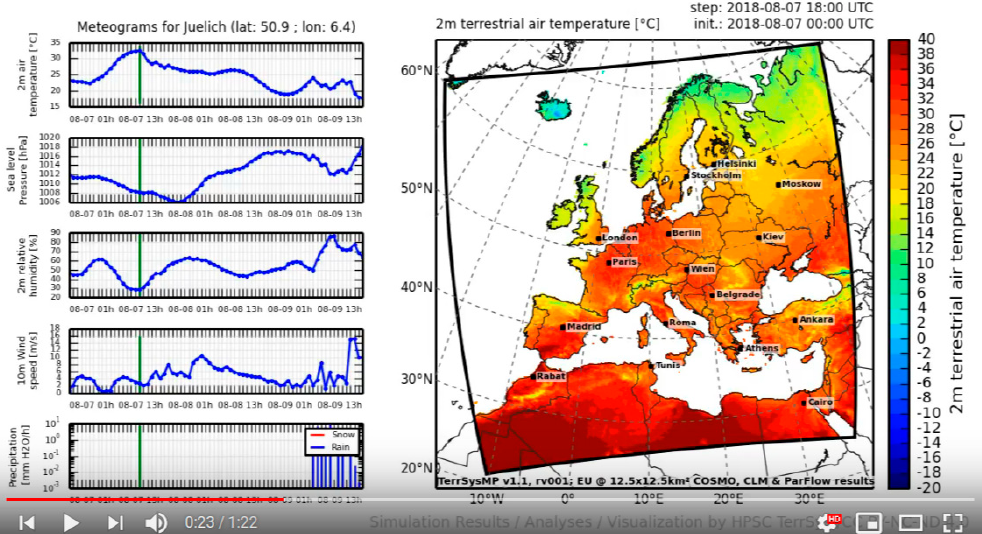
Figure 5. Monitoring output of TSMP (CORDEX EUR-11 domain) for the terrestrial 2 m air temperature (°C) at the peak of the heat wave on 7 August 2018. On the left from top to bottom, the meteograms depict 2 m air temperature (°C), sea level pressure (hPa), 10 m wind speed (m·s − 1 ), and precipitation (mm·h − 1 ) in Jülich (latitute: 50.9, longitude: 6.4), Germany.